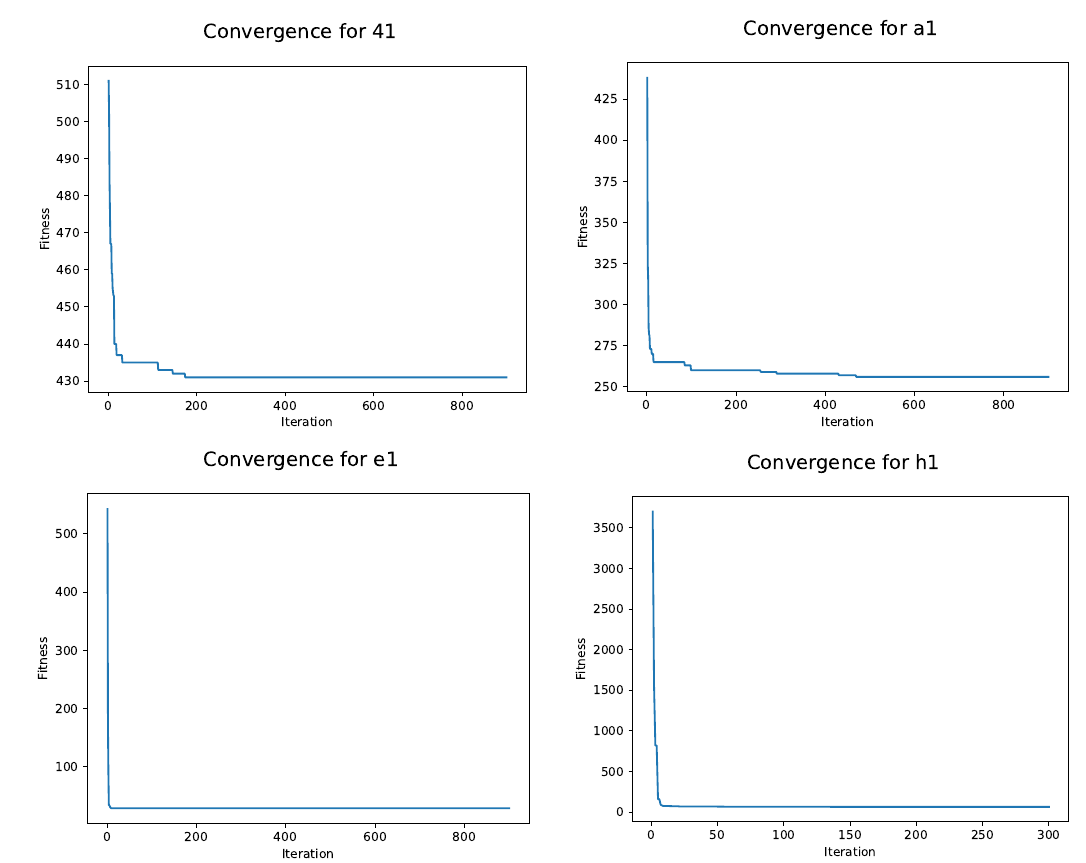
Figure 10. Convergence of HPSO. The algorithm shows improvements until approximately iteration 150, which represents 50% of the total